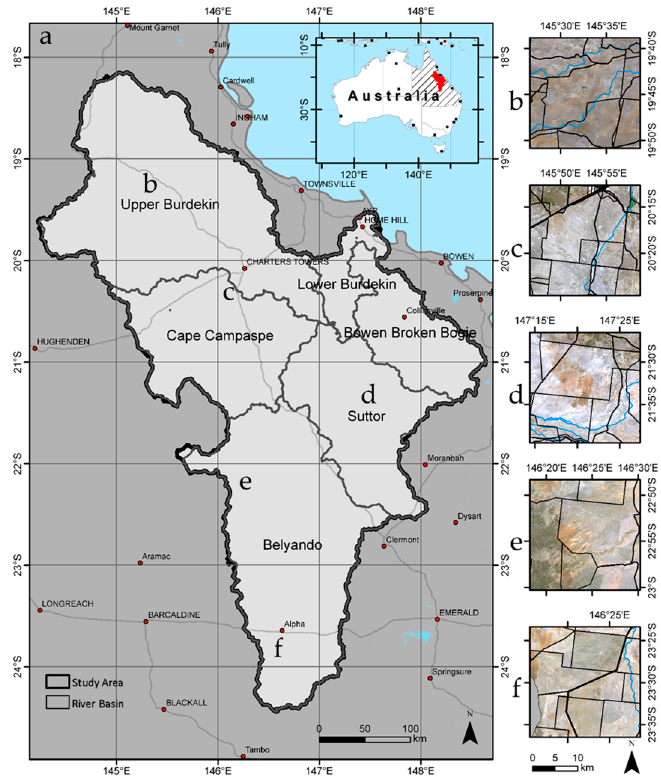
Figure 1. Location of the Burdekin Dry Tropics (BDT) region in the State of Queensland, Australia, the six major river basins ( a ) and five locations ( b – f ) identified as degraded by Jackson and Prince [23] and major roads and towns.